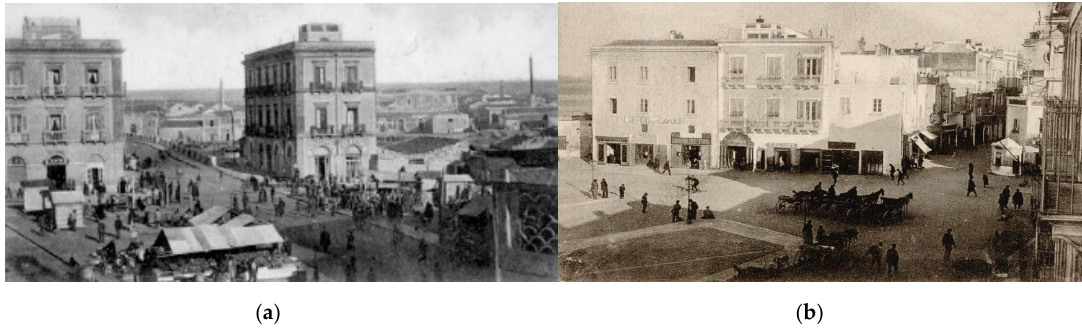
Figure 8. Photographic reconstruction of Piazza Fontana: ( a ) the square in 1901; ( b ) in 1920.